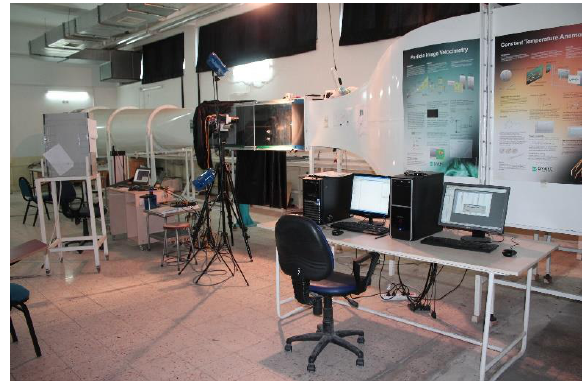
Fig. 1. Experimental set-up .